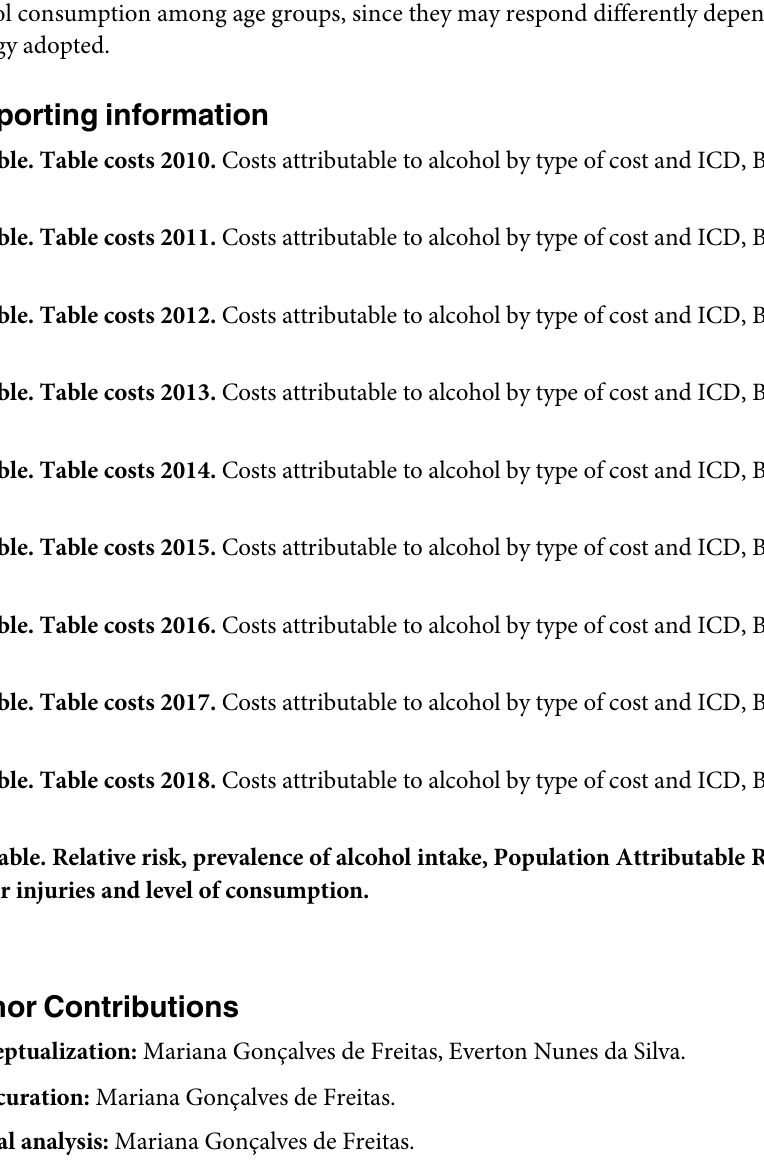
S2 Table. Table costs 2011. Costs attributable to alcohol by type of cost and ICD, Brazil, 2011. S3 Table. Table costs 2012. Costs attributable to alcohol by type of cost and ICD, Brazil, 2012. S4 Table. Table costs 2013. Costs attributable to alcohol by type of cost and ICD, Brazil, 2013. S5 Table. Table costs 2014. Costs attributable to alcohol by type of cost and ICD, Brazil, 2014. S6 Table. Table costs 2015. Costs attributable to alcohol by type of cost and ICD, Brazil, 2015. S7 Table. Table costs 2016. Costs attributable to alcohol by type of cost and ICD, Brazil, 2016. S8 Table. Table costs 2017. Costs attributable to alcohol by type of cost and ICD, Brazil, 2017. S9 Table. Table costs 2018. Costs attributable to alcohol by type of cost and ICD, Brazil, 2018. S10 Table. Relative risk, prevalence of alcohol intake, Population Attributable Risk by dis- ease or injuries and level of